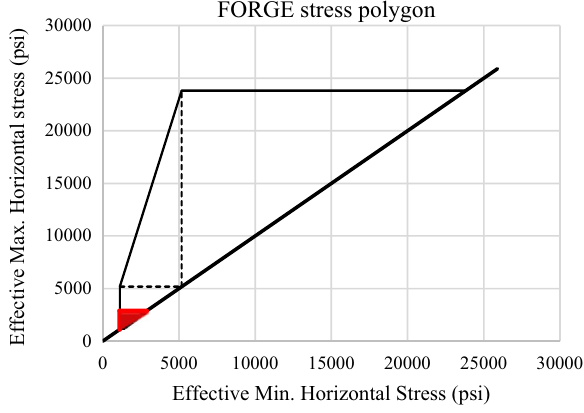
Fig. 4 Critical pressure, P c , for shearing activation computed using Eq. (2) at a depth of 7400 ft in well